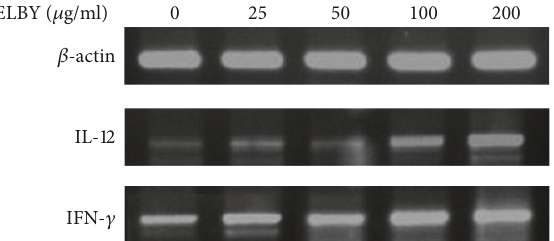
Figure 12: Changes in cytokine expression of murine splenocytes incubatedwiththepreparedmediafor24hours. Reversetranscription polymerase chain reaction ( RT-PCR) shows that both L-12 and INF- 𝛾 expressions were upregulated dose dependently by the incubation with the prepared